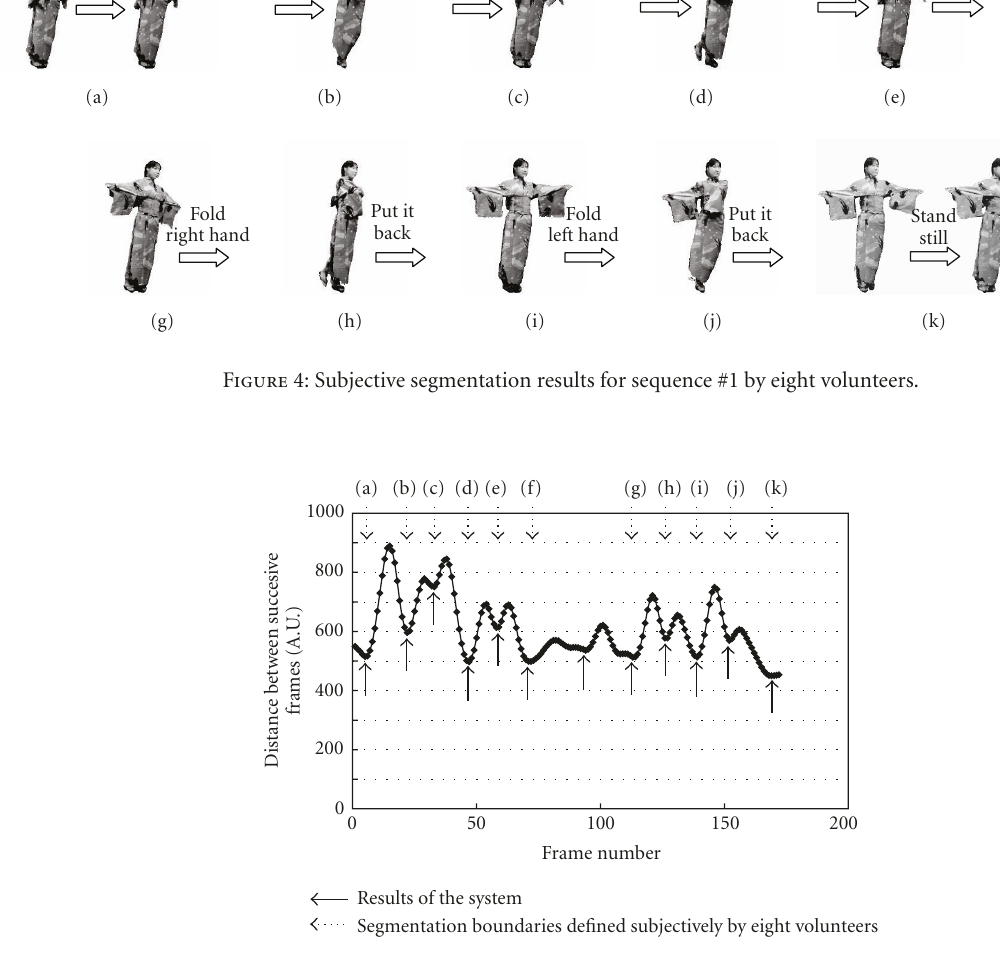
Figure 5: Comparison of subjectively defined segmentation points and results of our system for sequence #1. Dotted arrows from (a) to (k) represent the segmentation boundaries defined subjectively by eight volunteers. Solid arrows are the results of our system.